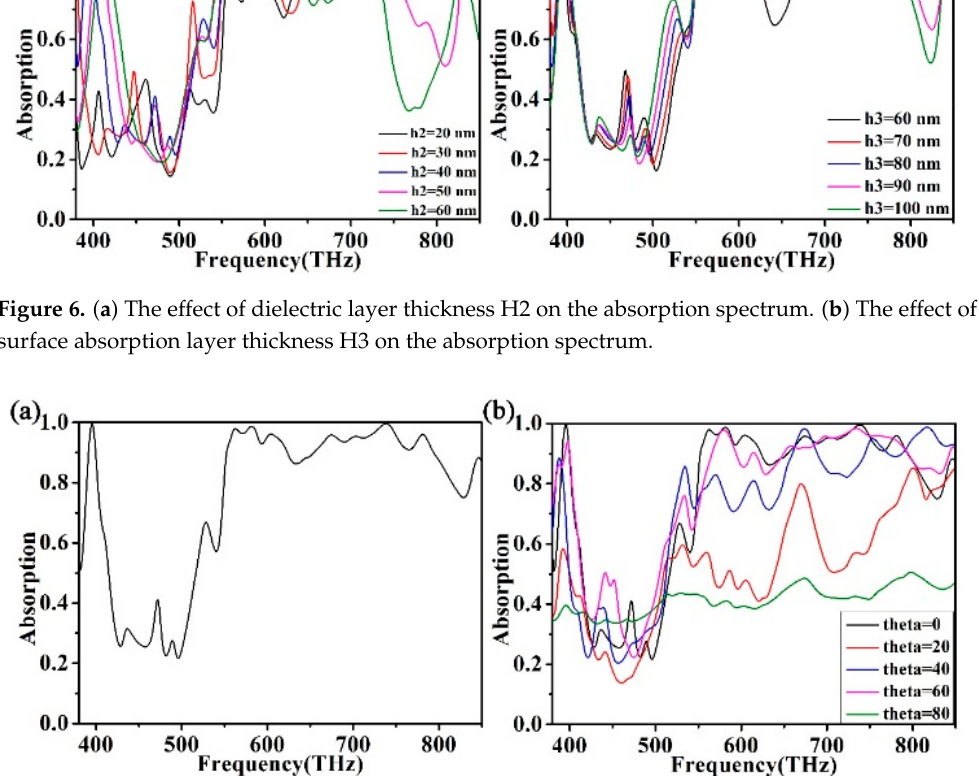
Figure 7. ( a ) The absorption curve under TM polarization (transverse magnetic, the electric field is parallel to the x direction). ( b ) The absorption spectrum of the absorber at different angles of inci- dence.